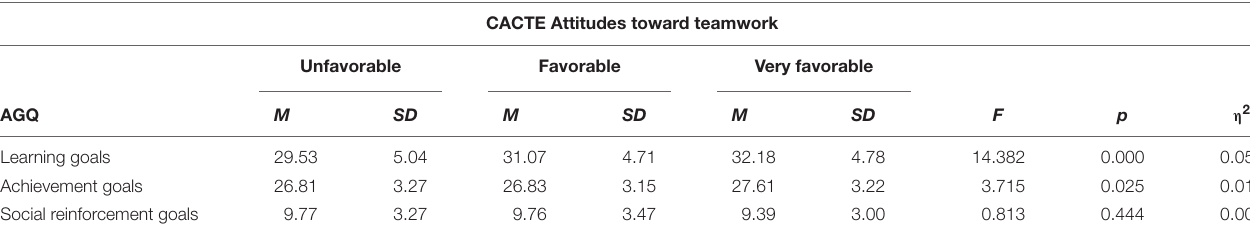
TABLE 9 | ANOVA AGQ Goals/Groups of Attitude toward